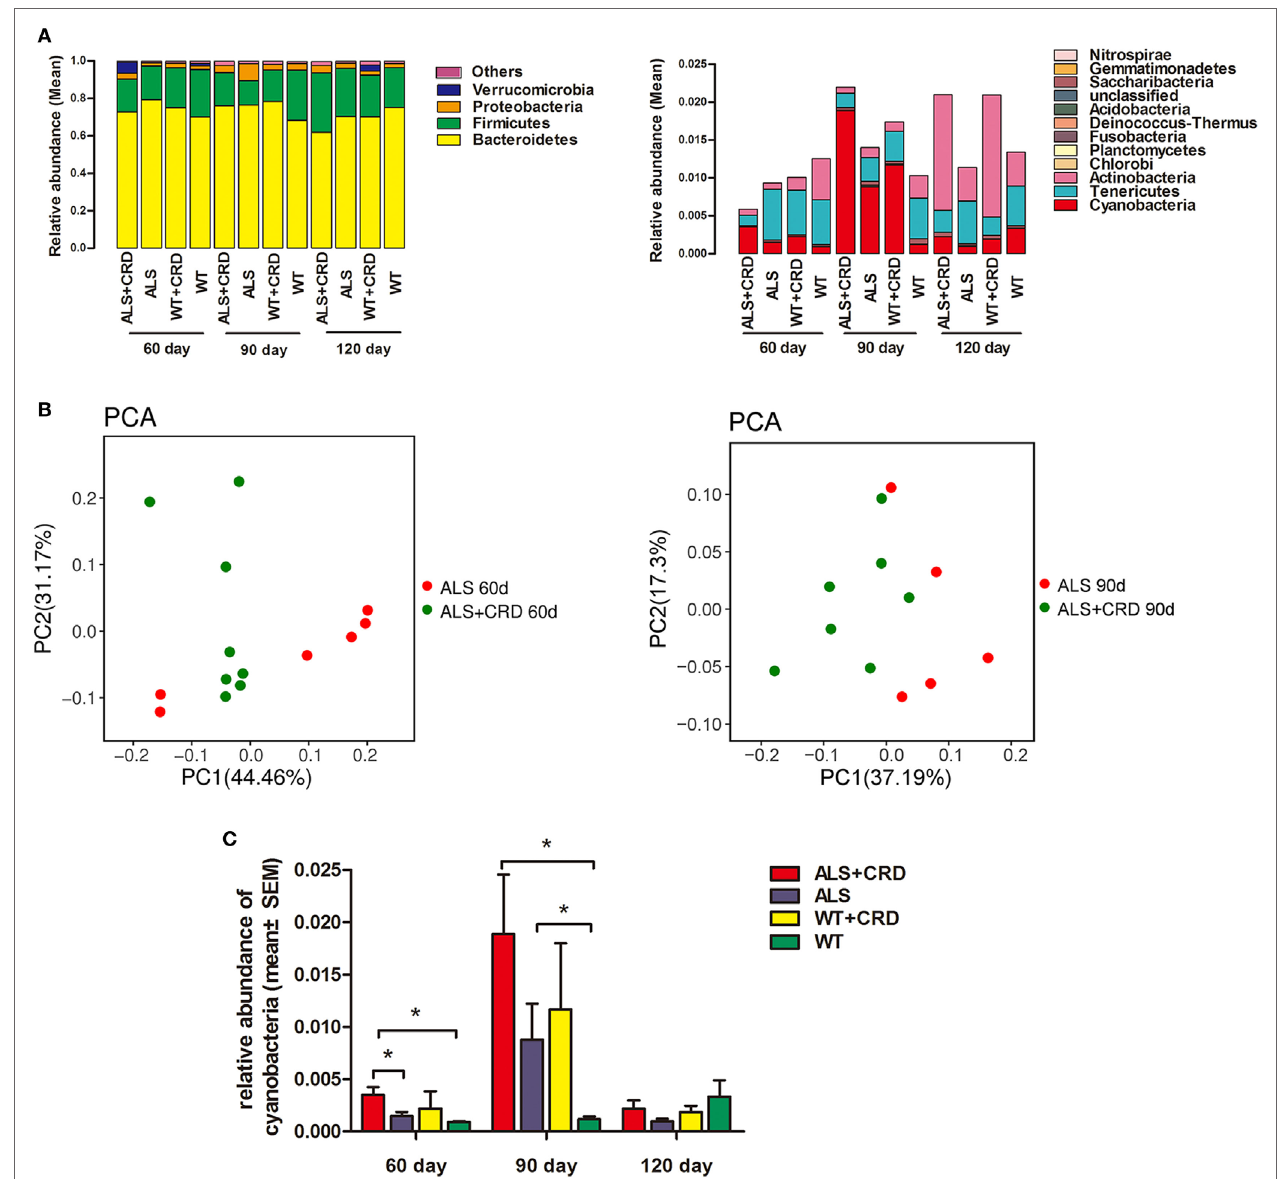
FigUre 4 | Circadian rhythm dysfunction (CRD) increased enteric cyanobacteria abundance in SOD1G93A mice. (a) Intestinal bacterial abundance profiles at the level of phylum among the four groups at three time points using 16S high throughput sequencing. Flora were presented in the form of averages. Sample capacity of each group was 4–8. (B) Differences and distances of each sample between the amyotrophic lateral sclerosis (ALS) + CRD group and the ALS group at day 60 and 90, respectively, reflected by Principle Component Analysis (PCA). (c) Comparisons of relative abundances of cyanobacteria among the four groups at different disease stages. N = 4–6 per group per time point, * p < 0.05. Error bars represent